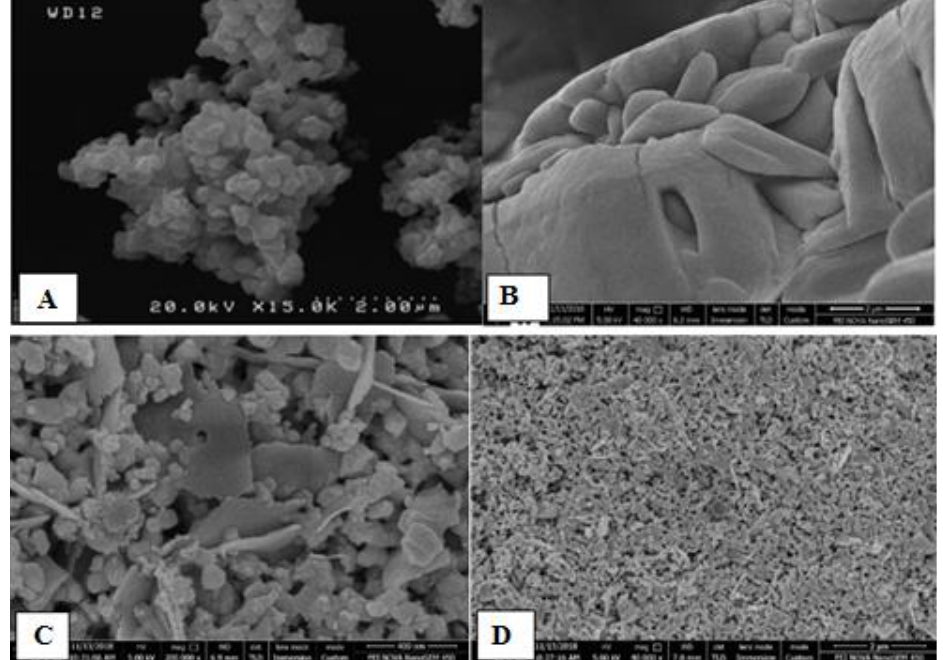
Fig. 1: SEM images (A: BFO image, B: CIP powder, C: BFO image after the reaction, D: BFO image after reaction by 400 nm magnification)